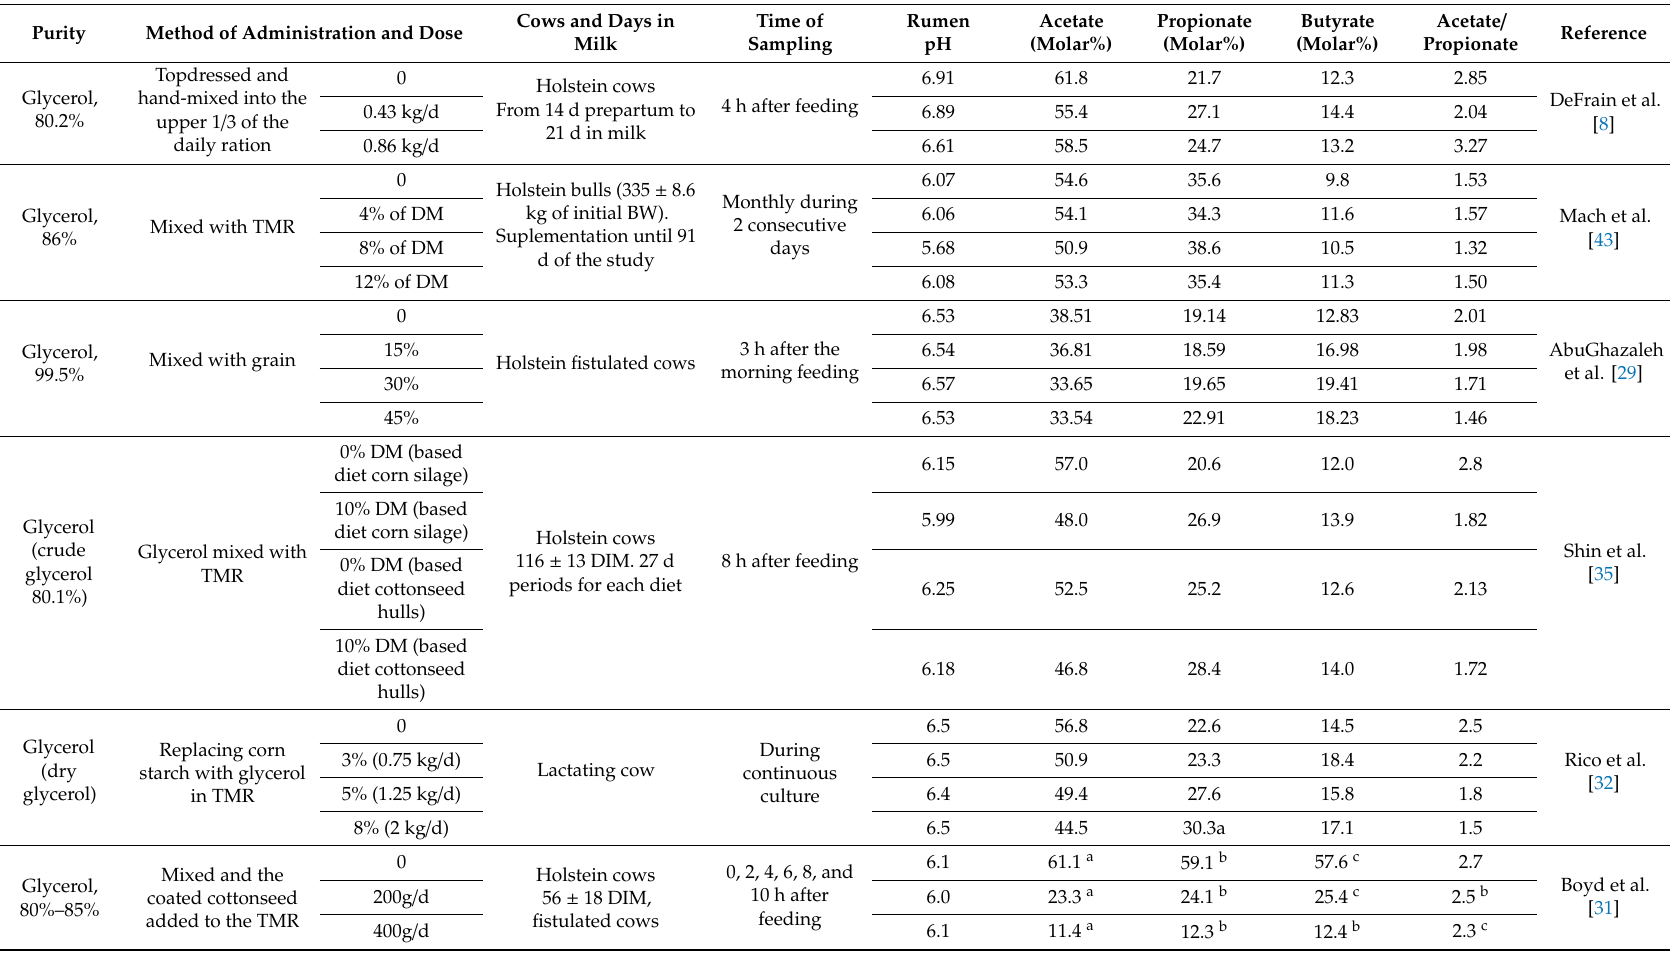
Table 1. The e ff ect of glycerol on the fermentation, microbiome, and pH in the rumen of